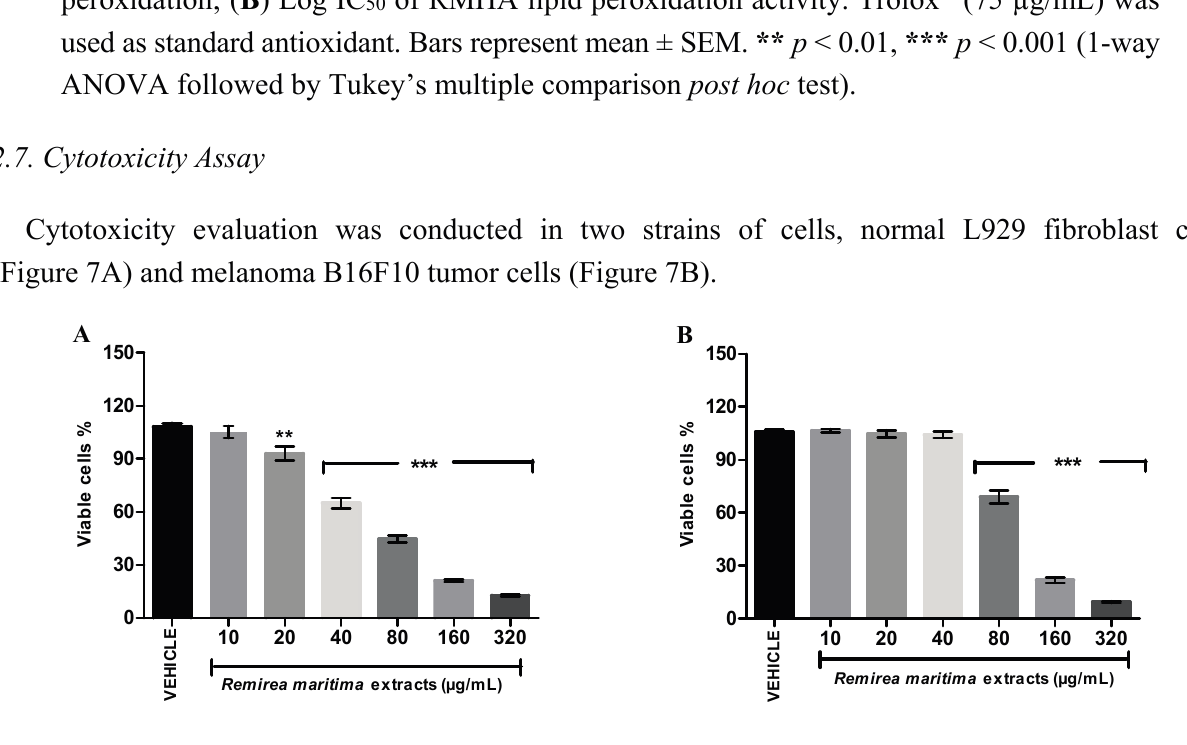
Figure 7. Effect of RMHA on cell viability at different concentrations assessed by a neutral red assay. ( A ) L929—fibroblast cells and ( B ) B16F10—melanoma cells. Control group received distilled water (1:1). n = 4, ** p < 0.01, *** p < 0.001 (1-way ANOVA followed by Tukey’s multiple comparison post hoc